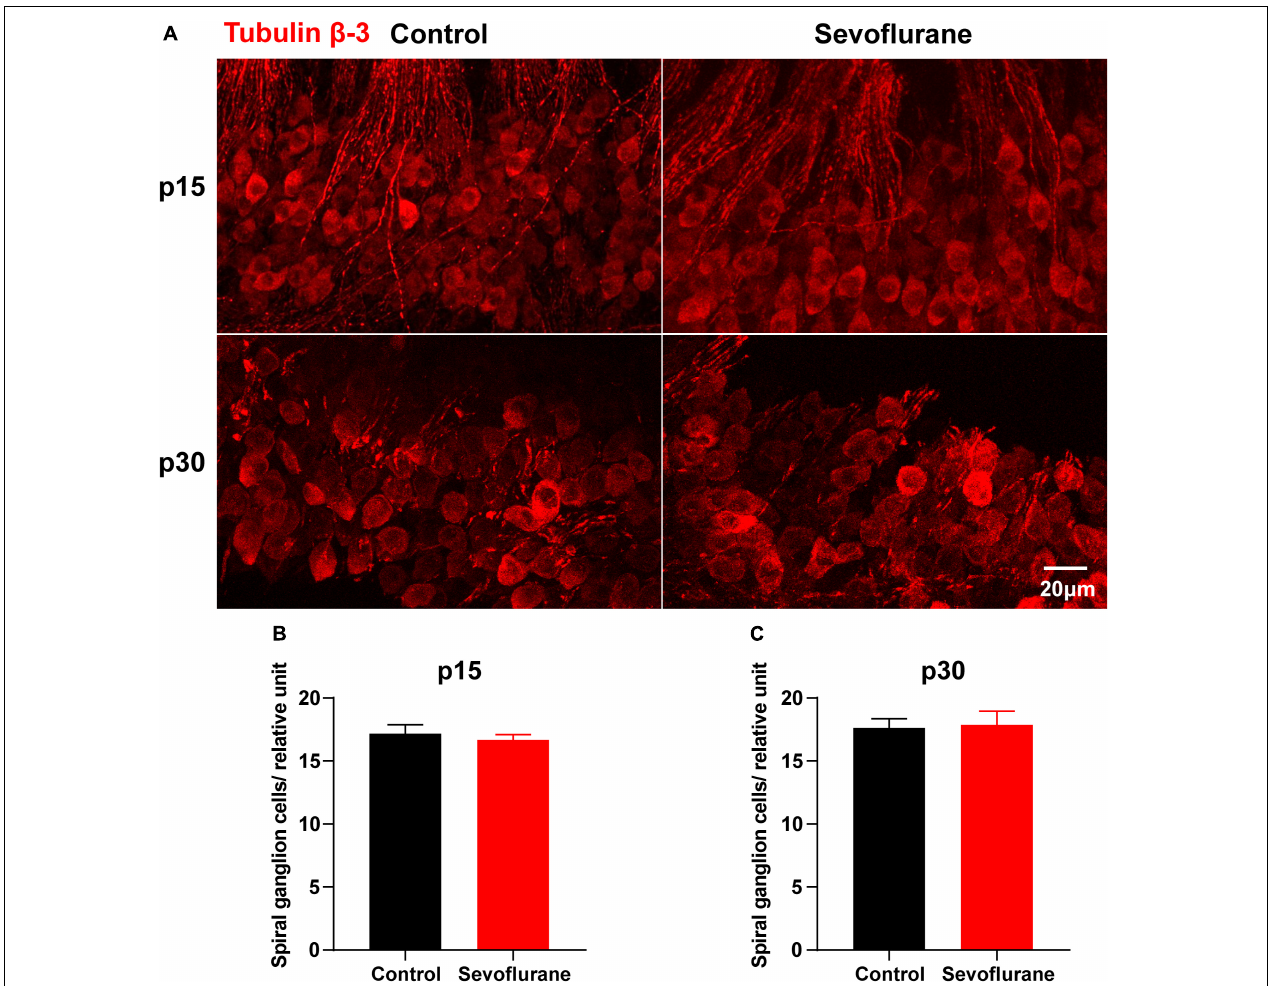
FIGURE 5 | Multiple sevoflurane exposures in naïve mice do not reduce the number of spiral ganglion neurons (SGNs). (A) Cell bodies of SGNs identified by immunostaining for anti-tubulin β -3 (red). (B) SGN density is comparable in the two groups on P15. (C) SGN density is comparable in the two groups on P30 ( n = 6 per group). P > 0.05, unpaired Student’s t -test. Scale bar = 20 µ